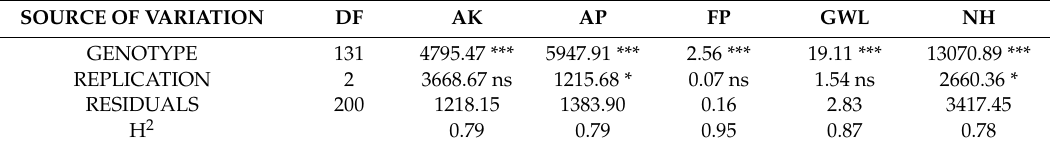
Table 2. Results of the analysis of variance for maize weevil (MW) resistance traits.